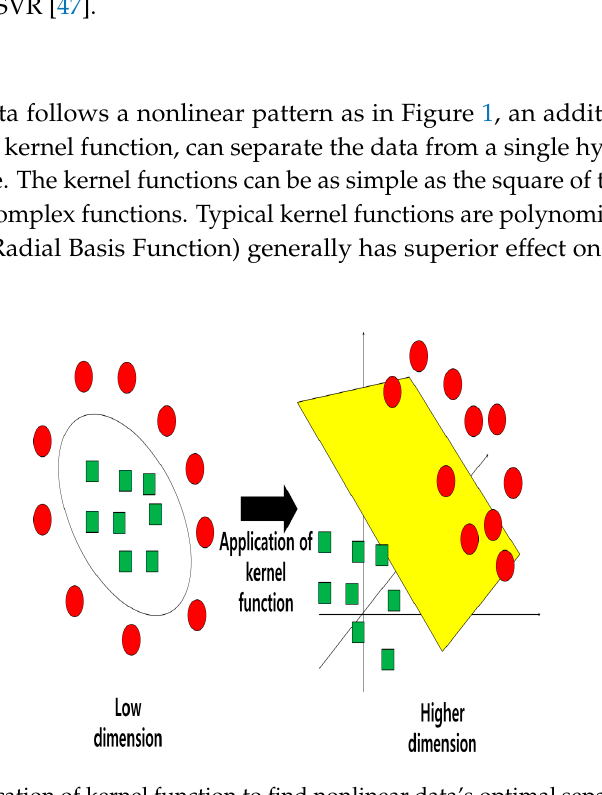
Figure 1. Application of kernel function to find nonlinear data’s optimal separation plane.